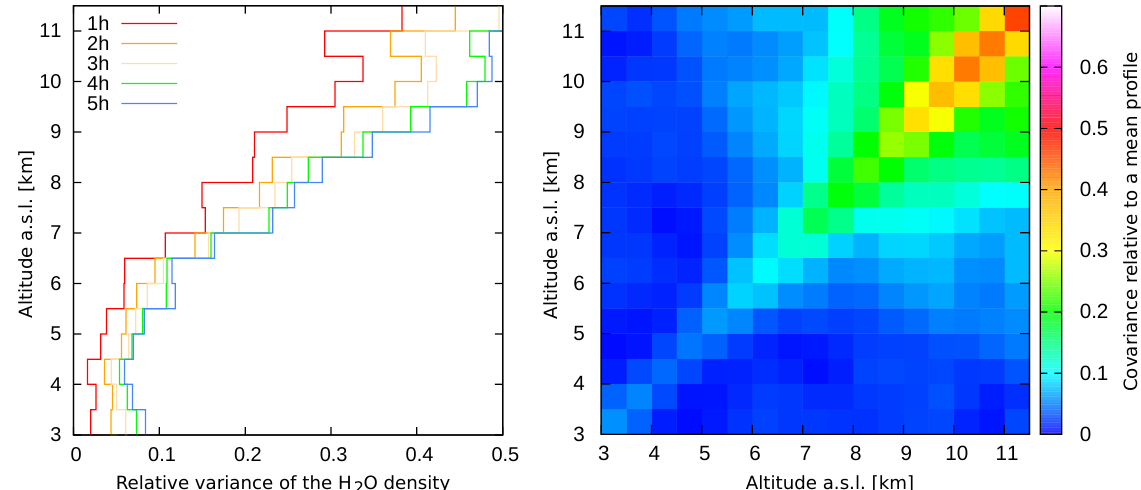
Figure 6. The short-term variability of the vertical water vapor profile is illustrated by the plot of the relative variance as a function of altitude within different time intervals (left plot). The covariance matrix (right plot) gives an idea of the interconnectivity of the variation between different